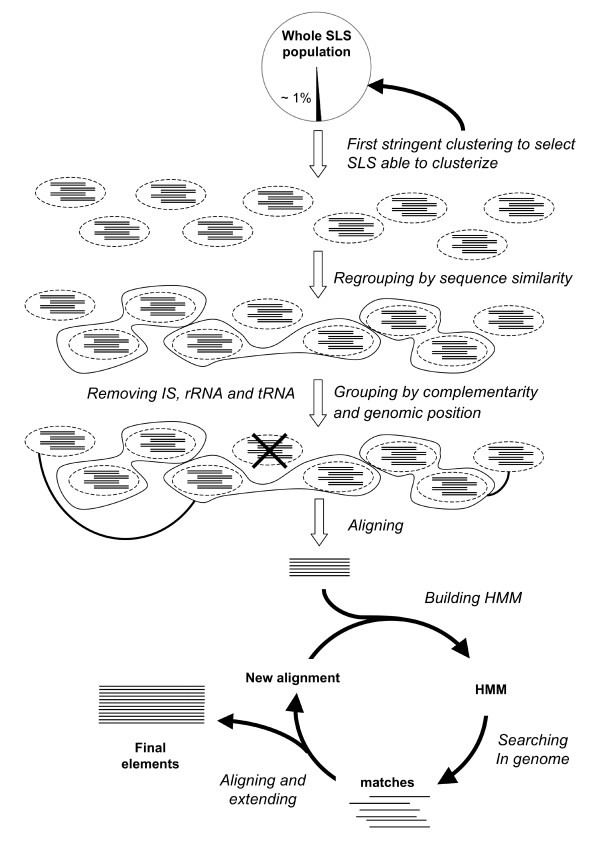
Schematic representation of the overall procedure.